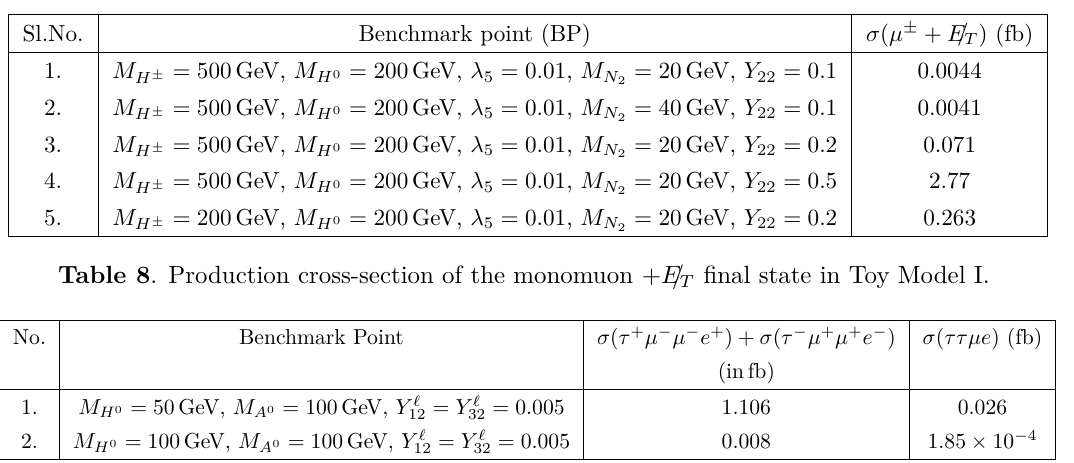
Table 9 . Possible signature of Toy Model II with the corresponding production